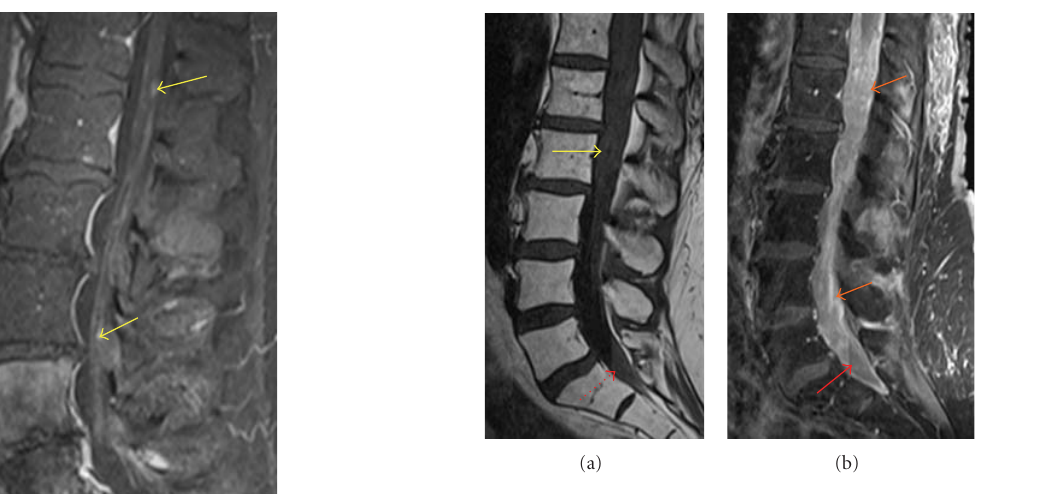
Figure 13: Sagittal T1-weighted MR image (a) shows a hazy ap- pearance of the subarachnoid space (yellow arrow) in the distal thecal sac. Fluid layers dependently in the thecal sac from blood pro- ducts and/or proteinaceous debris (red arrows). Sagittal enhanced T1-weighted MR image (b) with fat-saturation shows di ff use en- hancement of the CSF as well as thick sheet-like enhancement of the cauda equina (orange arrows) related to metastatic